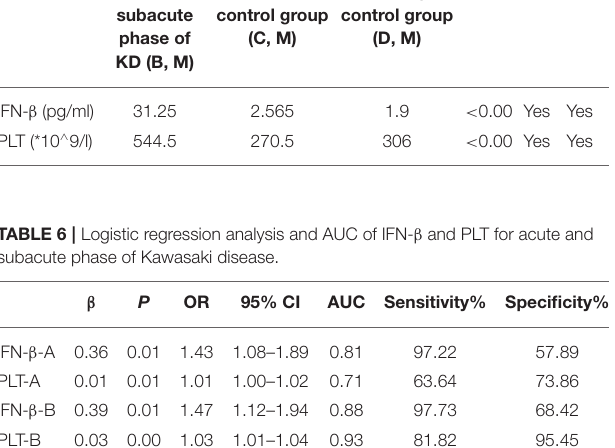
TABLE 5 | Comparison of IFN- β and PLT in the subacute phase of KD (B), febrile control group (C), and healthy control group (D). The subacute